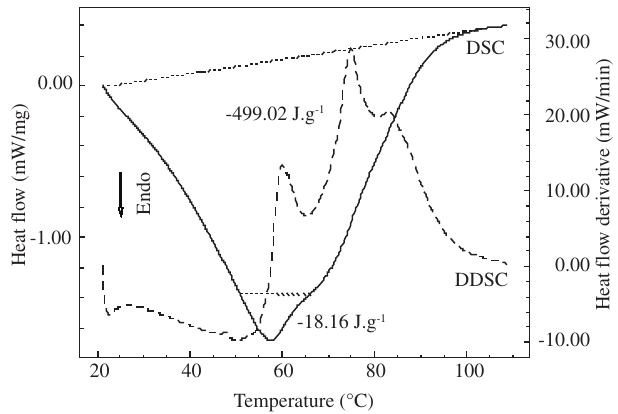
Figure 1. DSC/DDSC curves obtained in dynamic N (50 mL.min -1 ) and heating rate 10 °C.min -1 of the untreated bovine pericar- dium sample.